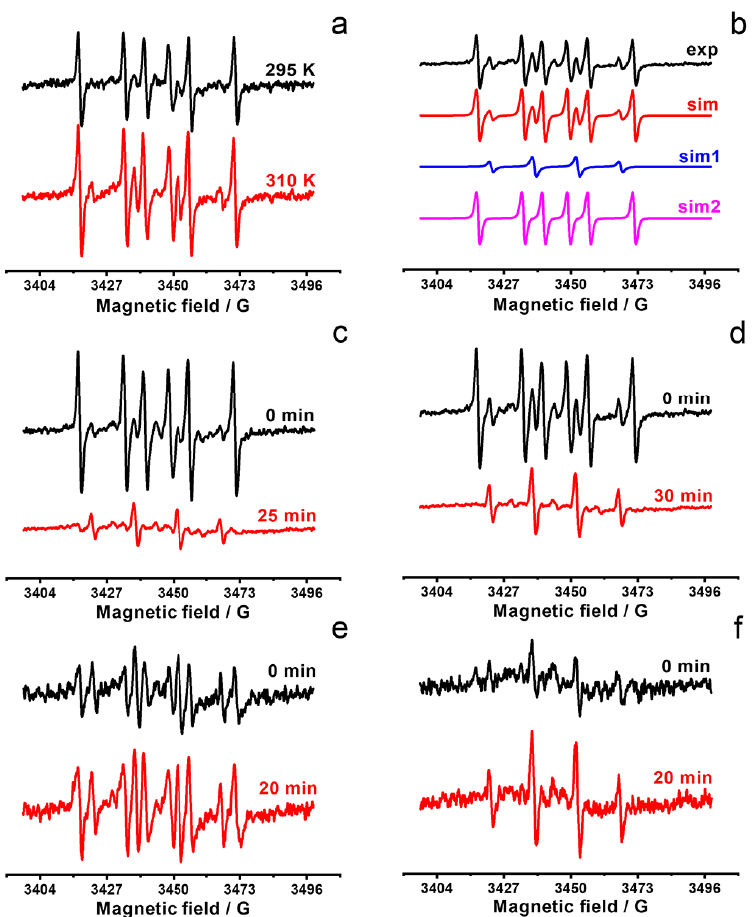
Figure 8. ( a ) ESR spectra of F-127-Cu 2 I 2 L 3 colloids at 295 K and 310 K (pH = 5.2). ( b ) Experimental (exp) and simulated (sim) spectra of F-127-Cu 2 I 2 L 3 colloids and simulated spectra of DMPO-OH· (sim1) and DMPO-R· (sim2) spin-adducts. ( c – f ) ESR spectra of F-127-Cu 2 I 2 L 3 colloids at pH = 5.2 ( c ), in the presence of H 2 O 2 (pH = 5.2, C = 200 µ M) ( d ), at pH = 7.0 ( e ) and in the presence of GSH (pH = 5.2, C = 400 µ M) ( f ), recorded right after sample preparation and after 20–30